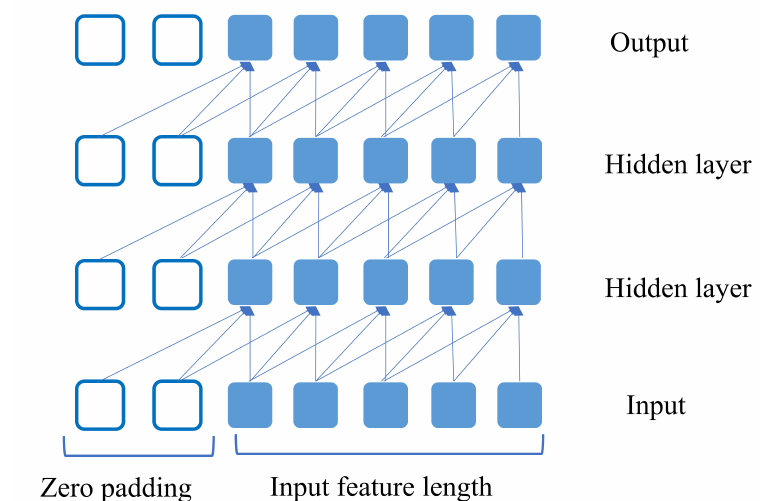
Figure 2. Example TCN with 4 layers where the number of input features is 5 and output is also 5.